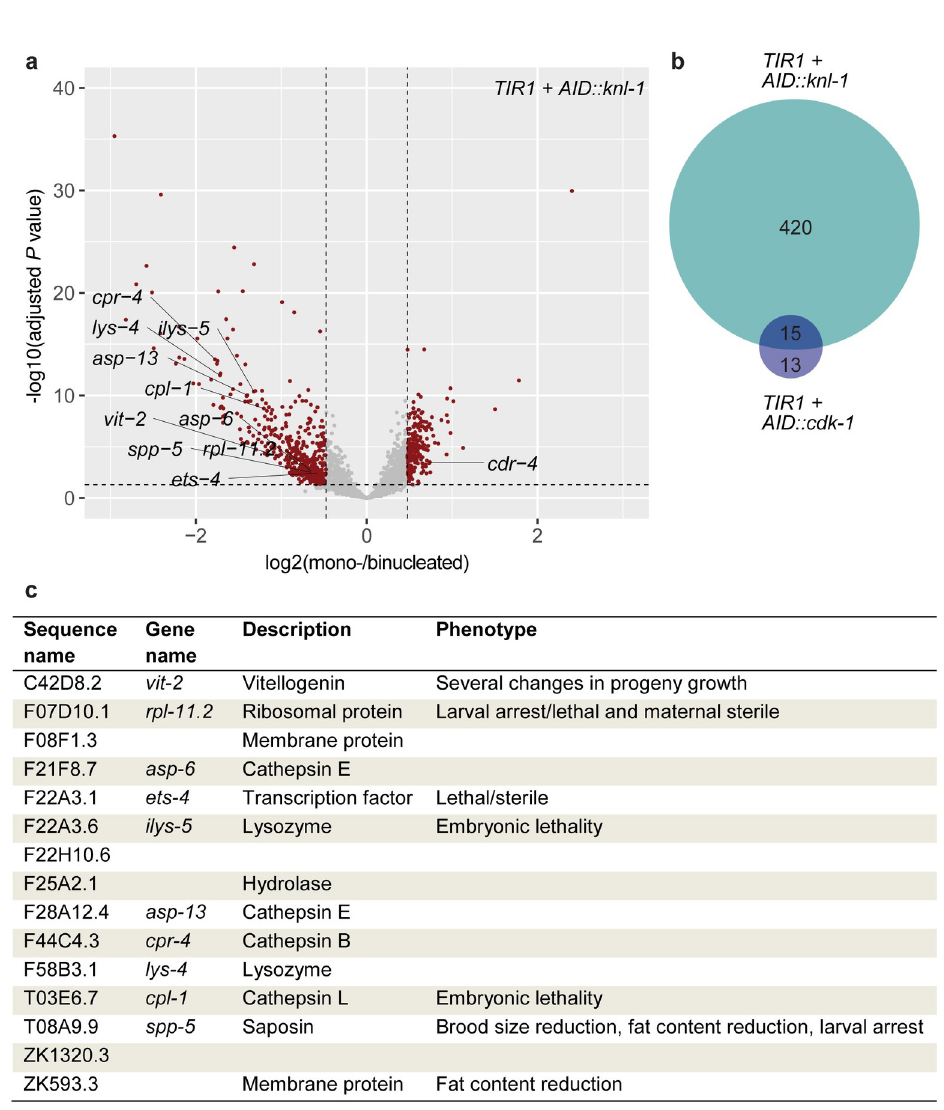
(Fig 3B and 3C). One of the genes that stood out was vit-2 , 1 of the 6 C . elegans vitellogenin genes whose levels have been shown to correlate strongly with the growth and fitness traits of C . elegans progeny [33]. Vitellogenins are highly expressed in adult intestines and are essential